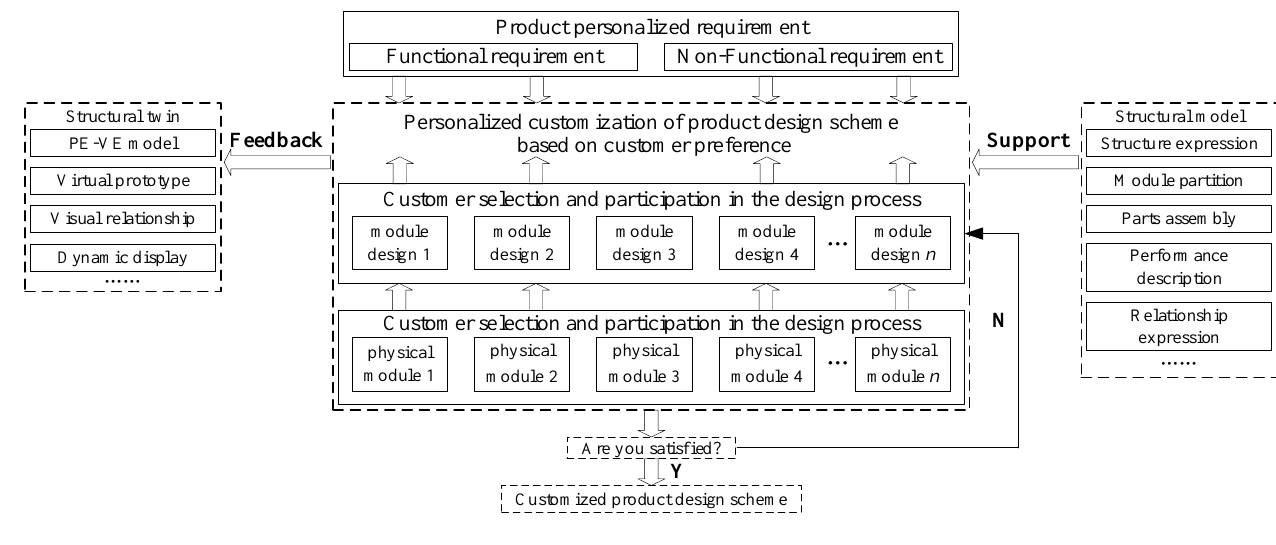
Figure 5. Identification of design requirements based on DMS-DT.